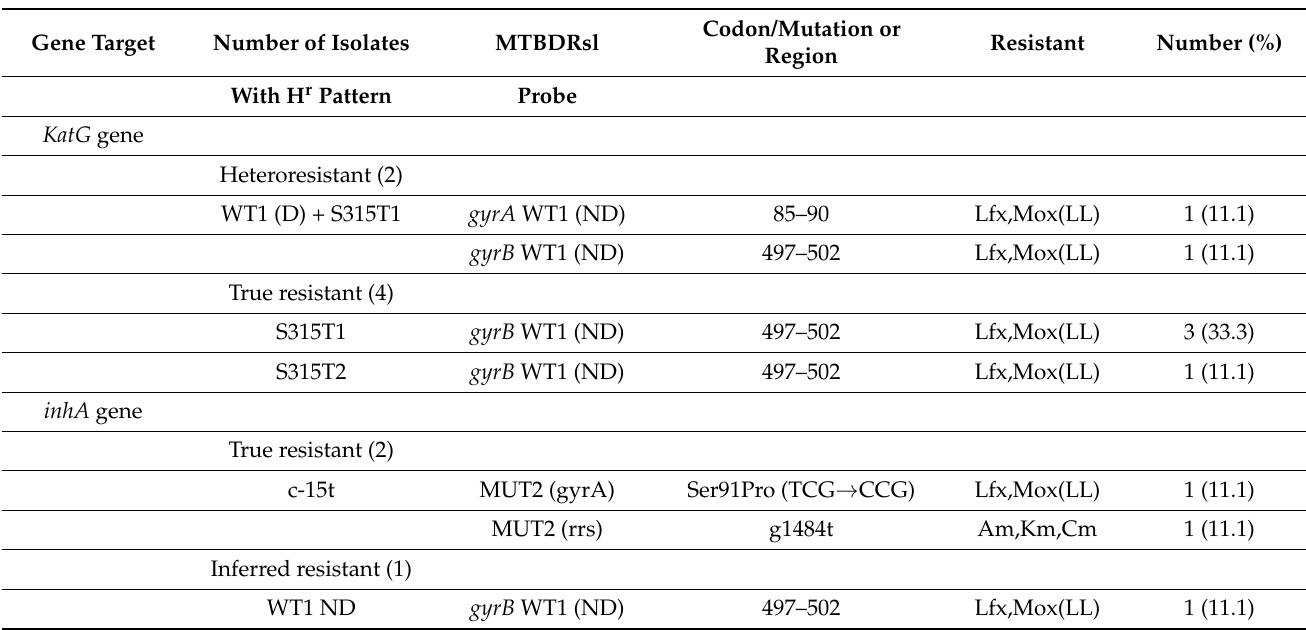
Table 2. Characteristics of gyrA and gyrB gene mutations in 200 isoniazid-resistant